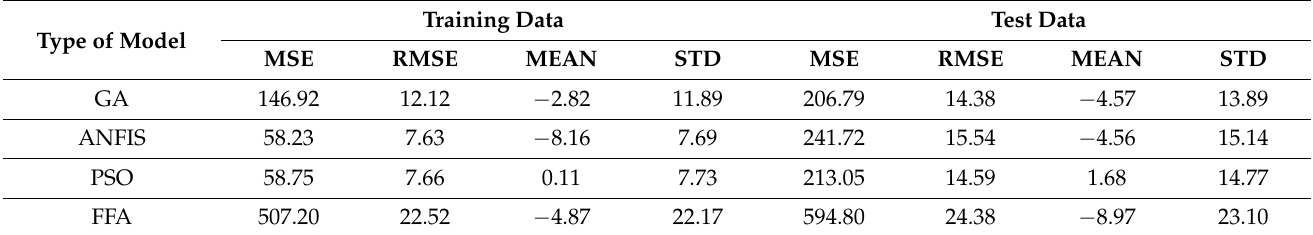
Table 6. Summary of model accuracy indicator test during the testing period, provided by